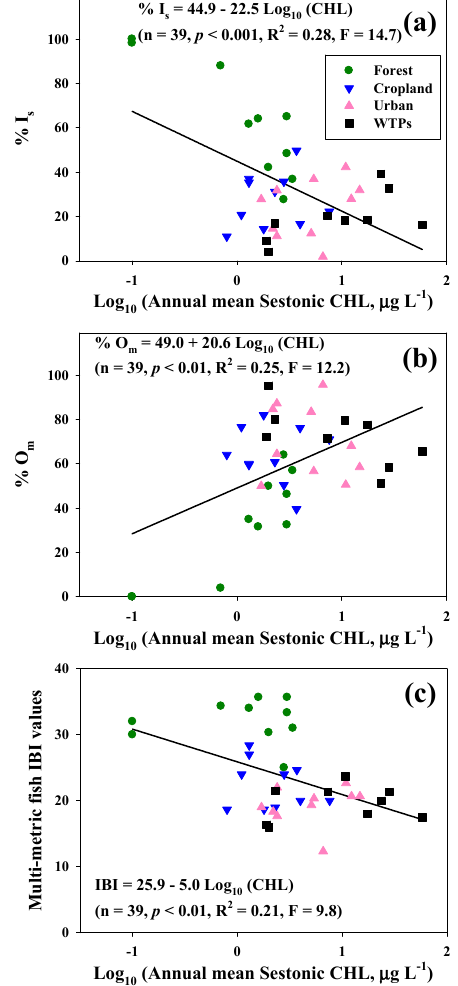
Figure 6. Simple linear regression models of ( a ) log 10 -transformed annual mean sestonic CHL–% I s ; ( b ) log 10 -transformed annual mean sestonic CHL − % O m ; ( c ) log 10 -transformed annual mean sestonic CHL − multi-metric fish IBI values, respectively.